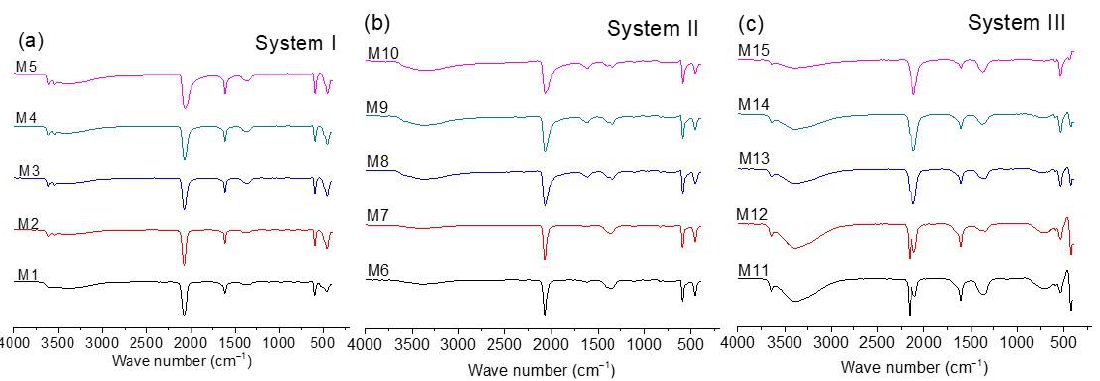
Figure 3. FTIR spectra for CoHCFs prepared by mixing Co(NO 3 ) 2 with ( a ) Na 4 [Fe(CN) 6 ], system I; ( b ) K 4 [Fe(CN) 6 ], system II; ( c ) K 3 [Fe(CN) 6 ], system III.